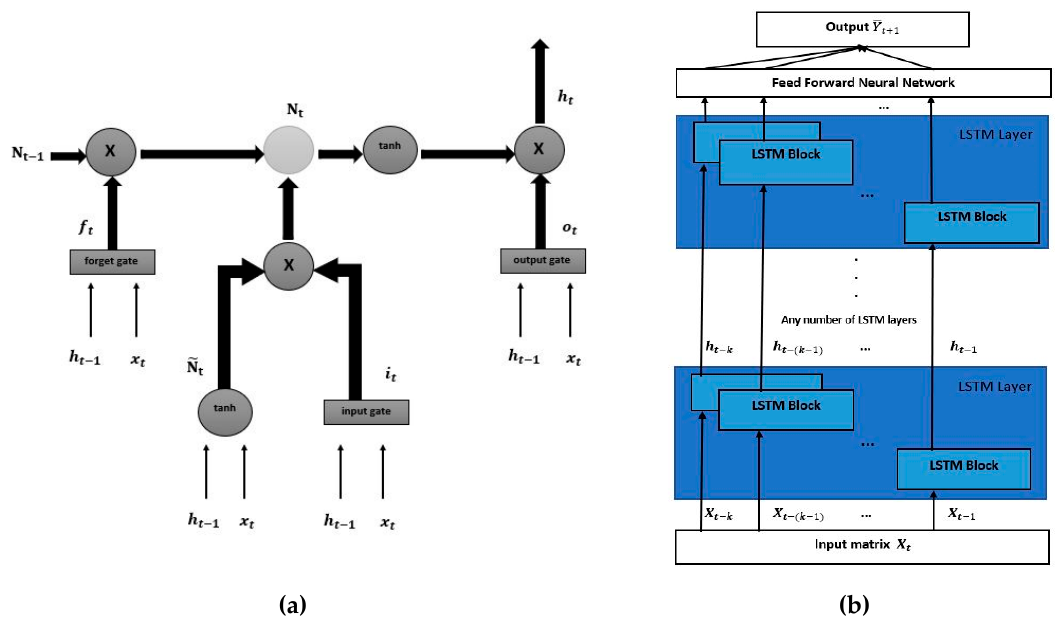
Figure 2. ( a ) Long short-term memory (LSTM) cell structure and ( b ) forecasting framework of LSTM neural network